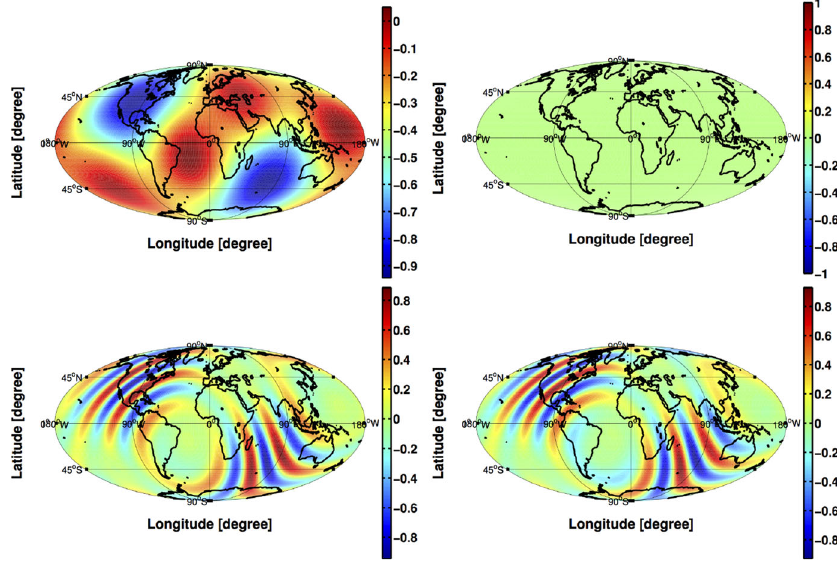
Fig. 43 Real and imaginary parts of γ( f , ˆ n ) (appropriately normalized) for the strain response of the 4- km LIGO Hanford and LIGO Livingston interferometers for f = 0 Hz ( top two plots ) and f = 200 Hz ( bottom two plots ). In the top left plot , note the large blue region in the vicinity of the two detectors, corresponding to the anti-alignment of the Hanford and Livingston interferometers—i.e., the arms of the two interferometers are rotated by 90 ◦ with respect to one another. As shown in the top right plot , there is no imaginary component to the integrand of the overlap function at 0 Hz. The bottom two plots show multiple positive and negative oscillations (‘lobes’), which come from the exponential factor e − i 2 π f ˆ n · Δ (cid:5) x / c of the product of the two response functions (5.43). The location of the positive and negative lobes are shifted relative to one another for the real and imaginary parts. The separation between the lobes depends inversely on the